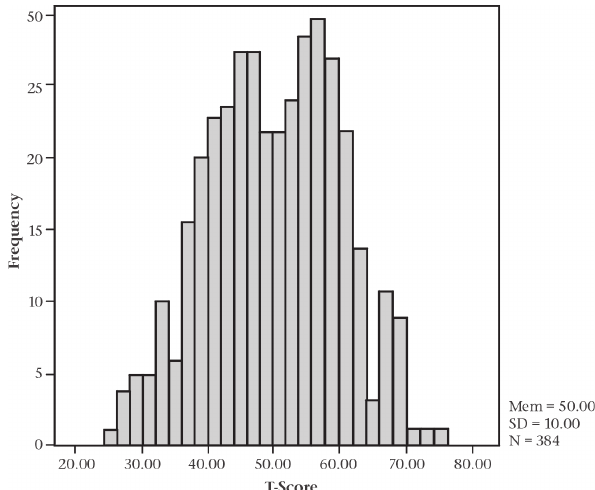
Figure 2: Histogram of anxiety scores From Figure 2 it is clear that the distribution of the IPAT Anxiety scores is virtually a normal distribution. These scores will be used as criterion (DV) in the rest of the study. As previously mentioned, there were complete records for 259 participants, therefore the rest of the study is based on 259